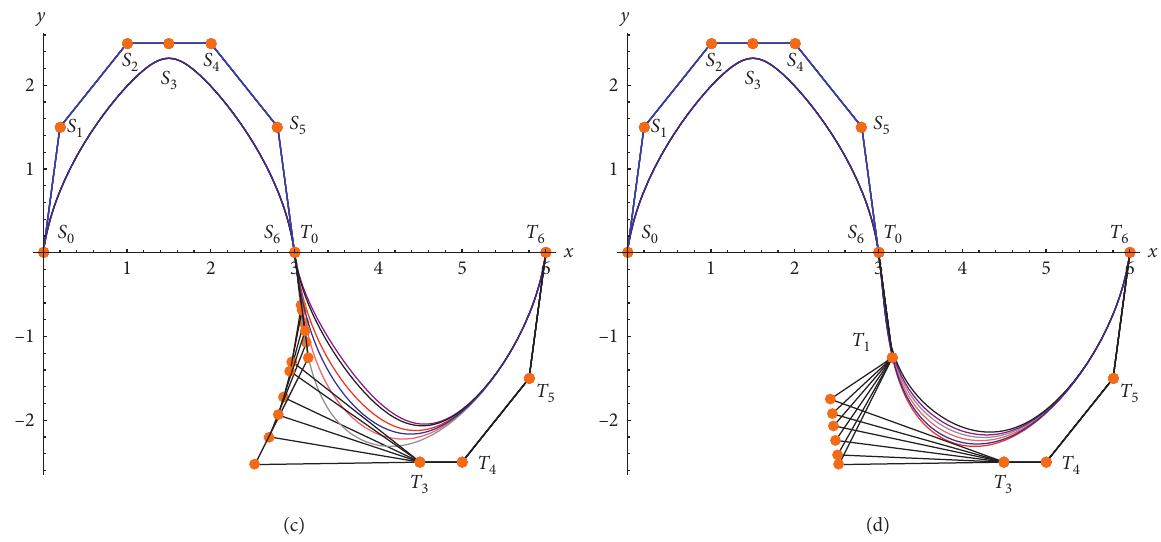
Figure 10: G 2 continuity of ST-B´ezier curve segments with various shape parameters. (a) μ � ω � μ 1 � ω 1 � 0 , 0 . 2 , 0 . 5 , 0 . 6 , 0 . 8 , λ � 1 . 8 , β � 1 . 1. (b) μ 1 � ω 1 � 0 , λ � 1 . 8 , β � 1 . 1 , μ � ω � 0 , 0 . 2 , 0 . 5 , 0 . 6 , 0 . 8. (c) μ � ω � μ 1 � ω 1 � 0 , β � 1 . 1 , λ � 1 . 2 , 1 . 4 , 1 . 6 , 1 . 8 , 2 . 2 , 2 . 4. (d) μ